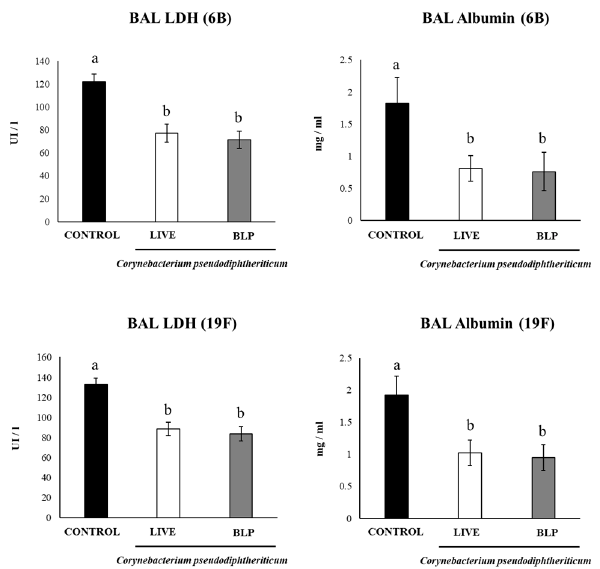
Figure 5. Resistance to Streptococcus pneumoniae infection induced by the immunization with the pneumococcal conjugate vaccine (PCV) plus Corynebacterium pseudodiphtheriticum 090104 or its bacterium-like particles (BLPs) in infant mice. Swiss albino infant mice (3 weeks old) were immunized by the nasal route with PCV or PCV plus C. pseudodiphtheriticum 090104 or it BLPs on days 0, 14, and 28. Five days after the last immunization (day 33), mice were nasally challenge with S. pneumoniae serotypes 6B or 19F. The determination of albumin and lactate dehydrogenase (LDH) in broncho-alveolar lavage (BAL) samples were performed on day 2 post-infection. Results represent data from three independent experiments and are expressed as mean ± standard deviation. Letters indicate significant differences between the groups ( p < 0.05).